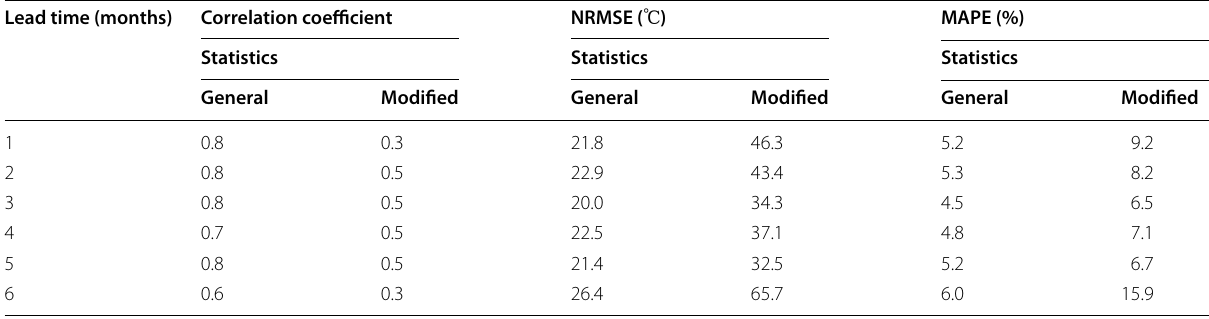
Table 12 Comparison of the predicted results of the monthly mean temperature obtained using the general and modified model according to the lead time Lead time (months)